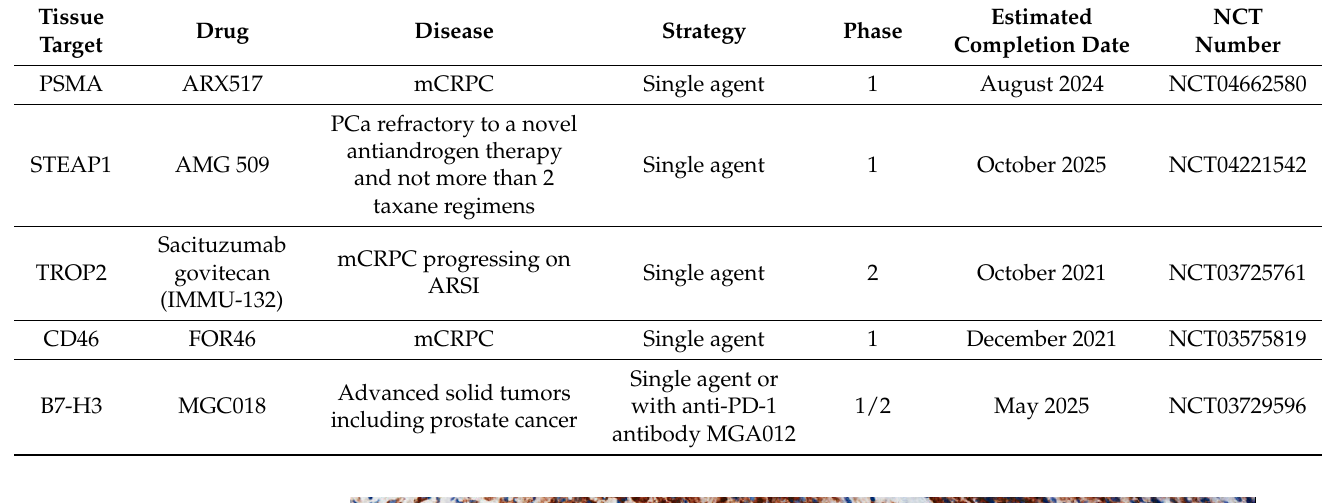
Table 2. The clinical trial data of ADCs in PCa. ARSI = Androgen Receptor Signaling Inhibitor; mCRPC = metastatic Castration-Resistant Prostate Cancer.